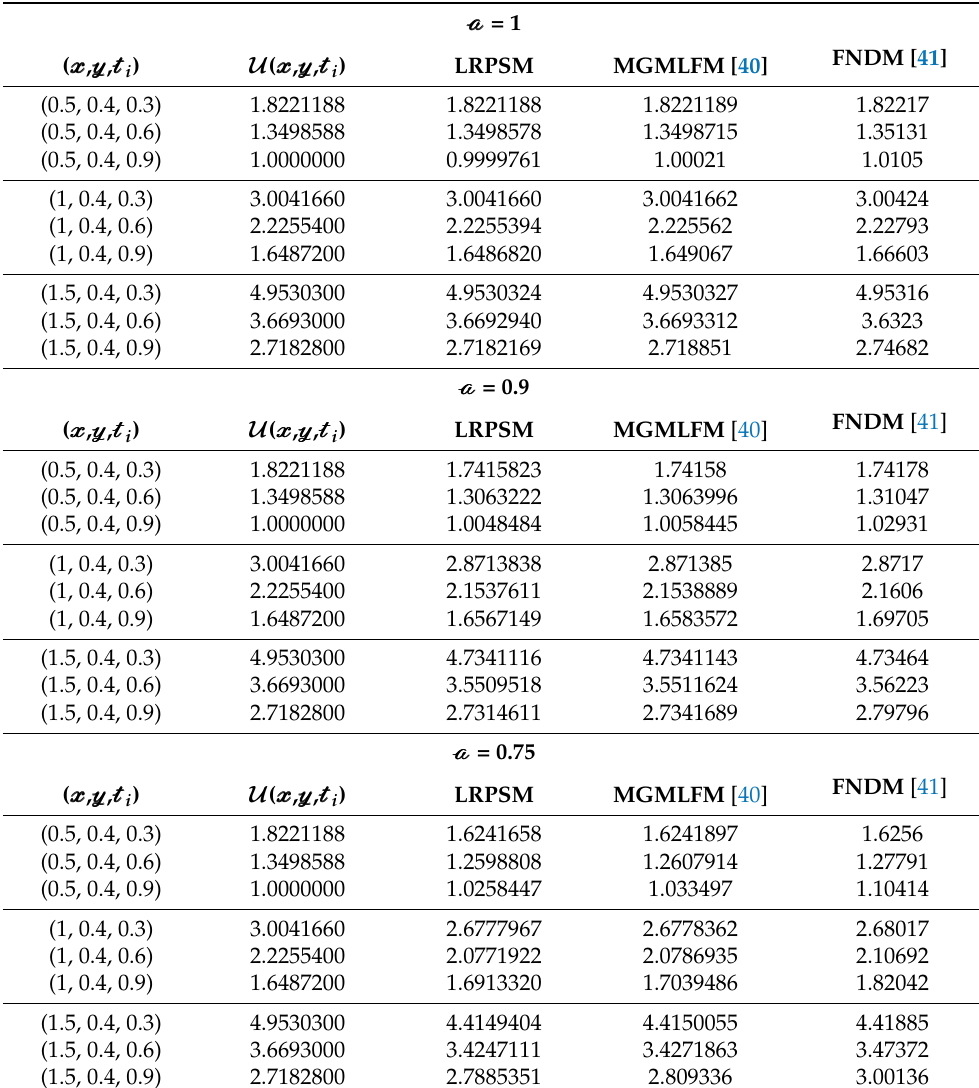
Table 10. Numerical comparisons for Example 3 at different values of 𝓍 , 𝒶 , and 𝓉 for the function U